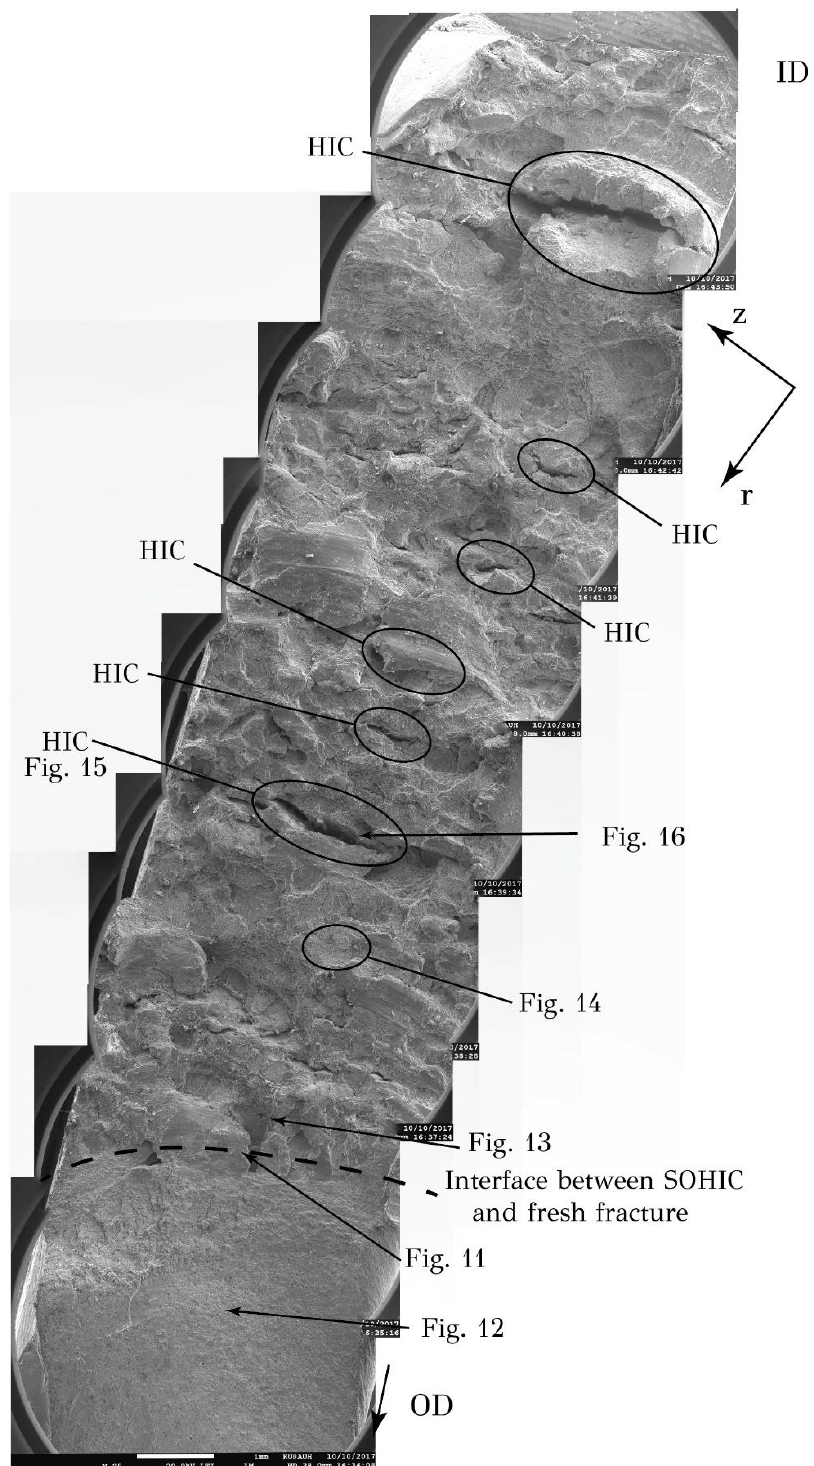
Figure 10. Assembly of SEM micrographs depicting the fracture surface of the opened SOHIC crack at position 500. The location of HIC cracks and individual SEM micrographs is indicated.